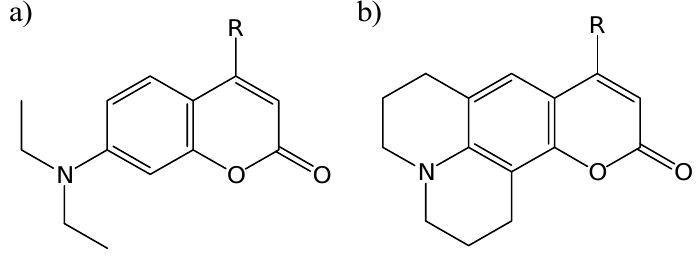
Figure 2 . The chemical structure of some commonly-used 7-aminocoumarin fluorescent : C1, also known as C460; R=CF probes. a) R=CH 3